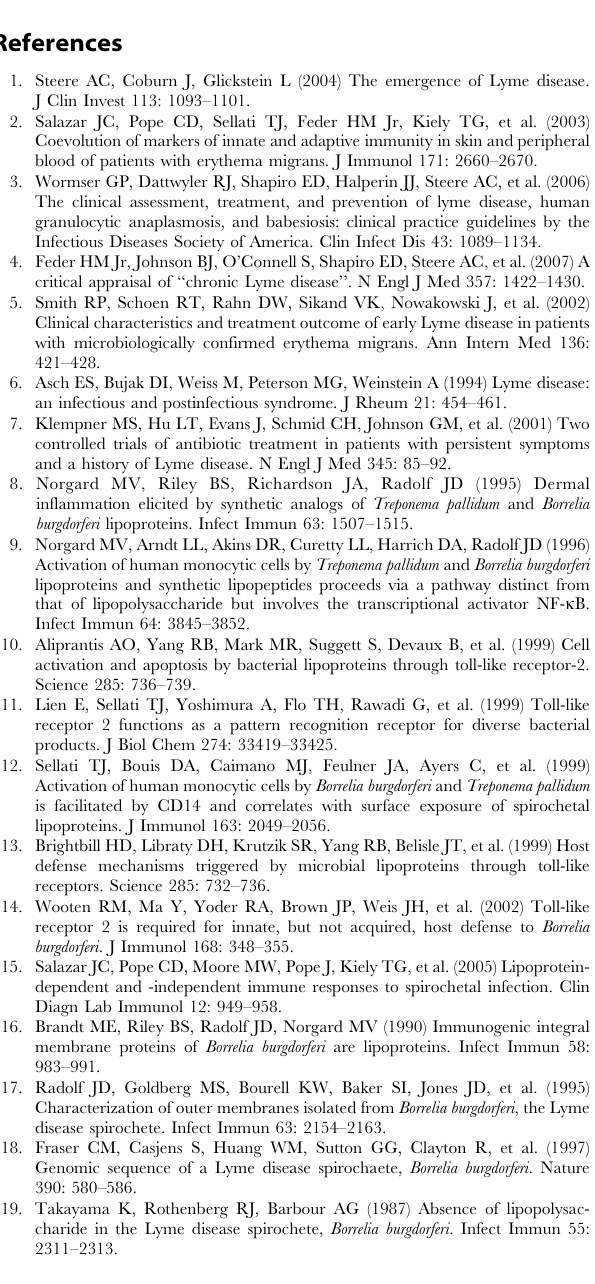
Table S2 Genes classified as being down-regulated in peripheral blood mononuclear cells (PBMCs) stimulated with live Borrelia burgdorferi (Bb) MOI (10:1), in comparison to cells stimulated with similar concentrations of borrelial lysates. Table S3 Genes more intensely or exclusively up-regulated by lysed B. burgdorferi . Table S4 Differentially regulated type I interferon associated